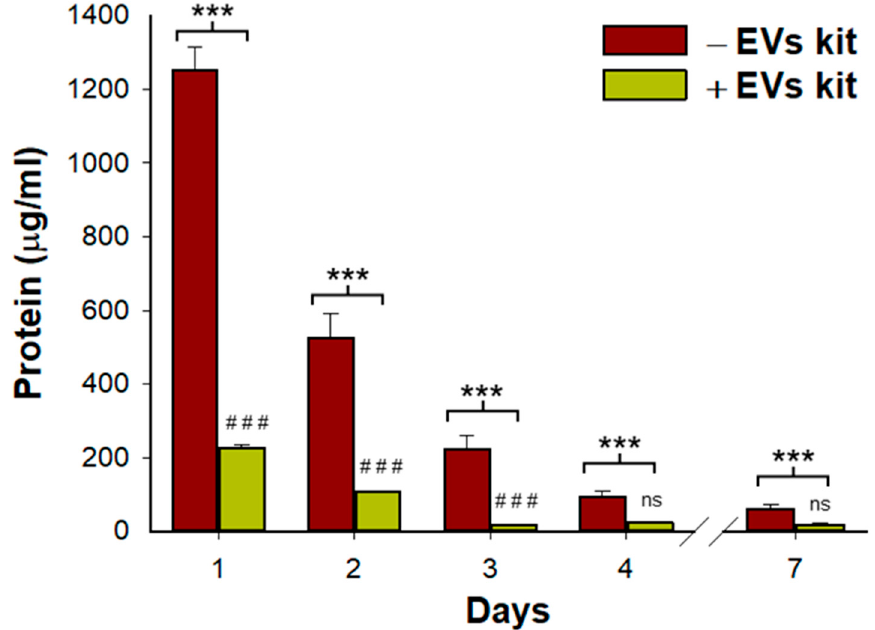
Figure 1. Total protein content and proteins released from bond ‐ ECM vesicles measured in L ‐ HG supernatants and after different daily washes. Whereas total protein was reduced every day, the portion of proteins from vesicles was reduced until day 3 reaching a plateau. ( n = 3 per group). * Comparisons between total protein and proteins from ECM ‐ vesicles and # represents comparisons between consecutive days in proteins from ECM ‐ vesicles. *** and ### p < 0.001.